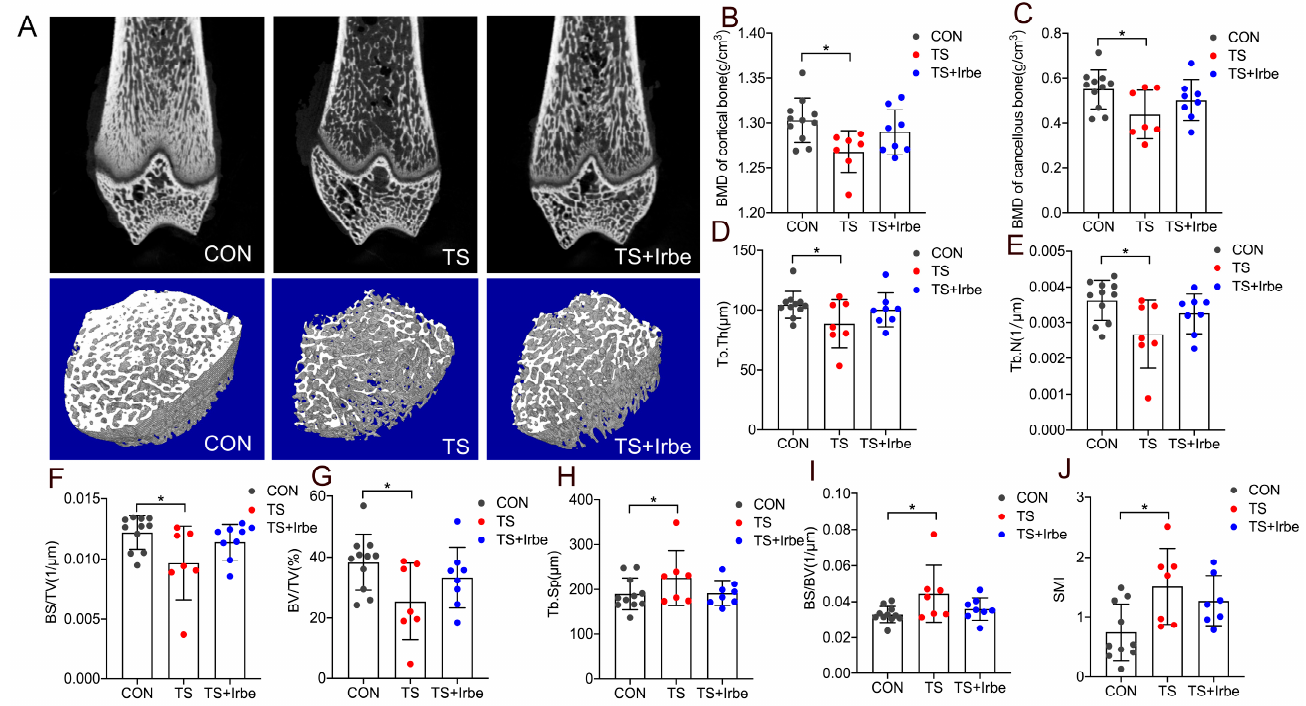
Figure 3. Inhibition of AGEs partially improved bone microstructure after tail suspension. ( A ) 2D reconstruction images of distal femur and 3D images of region of interest of trabecula. ( B ) BMD of cortical bone. ( C ) BMD of cancellous bone. ( D ) Tb.TI ( E ) Tb.N. ( F ) BS/TV. ( G ) BV/TV. ( H ) Tb.Sp. ( I ) BS/BV. ( J ) SMI. BMD: bone mineral density; Tb.Th: trabecular thickness; Tb.N: trabecular number; BS/TV: bone surface per tissue volume; BV/TV: bone volume per tissue volume;